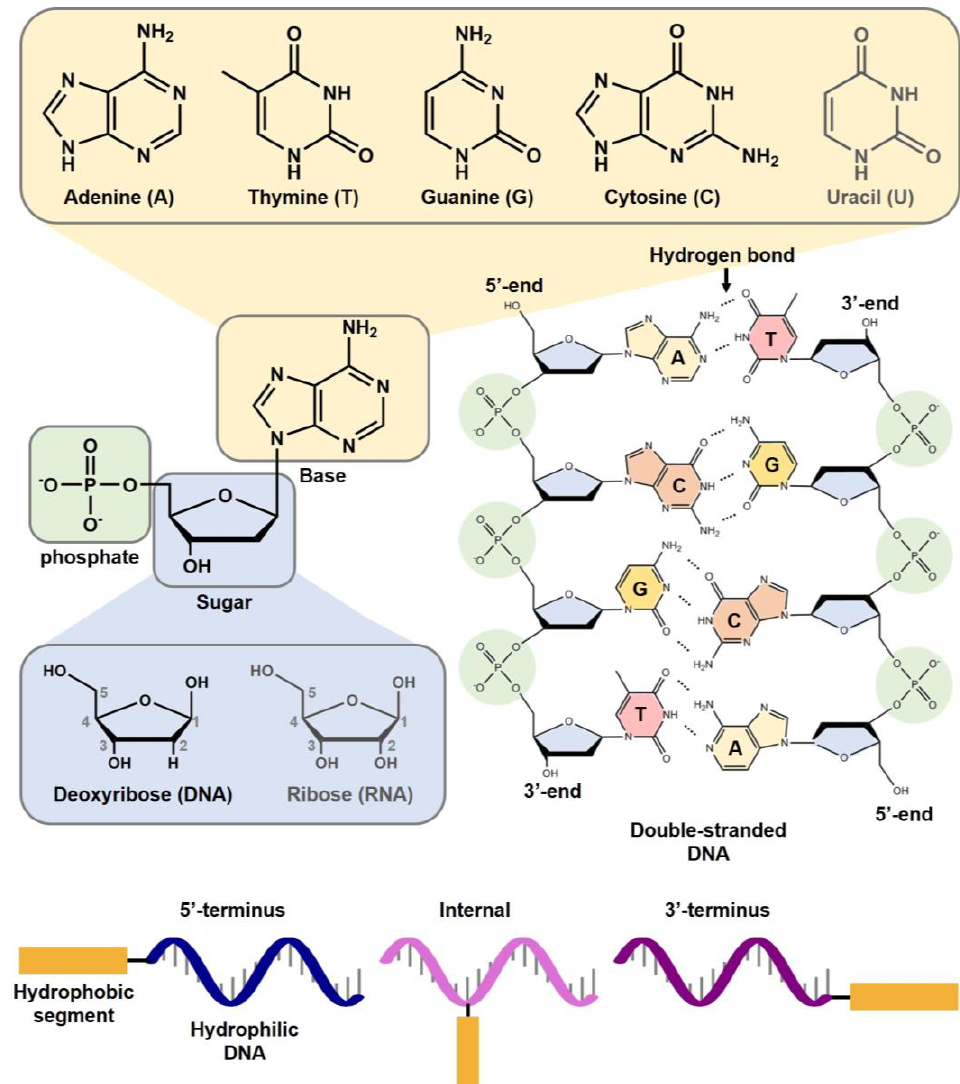
Figure 1. Schematic representation of a nucleotide, double-stranded DNA, and amphiphilic DNA. The nucleotide structure, including a phosphate, a sugar, and a base, is presented on the left. The structural difference between deoxyribose and ribose is shown below the nucleotide structure. The chemical structure of five nucleobases is presented at the top. A detailed structure of double-stranded DNA, composed of two chemically synthesized oligodeoxyribonucleotides, is presented on the right side. The 5’-end and 3’-end indicate the anti-parallel directionality of dsDNA. The dotted lines denote the hydrogen bonds between nucleobases. The positions of hydrophobic segments in amphiphilic DNA are shown at the bottom.